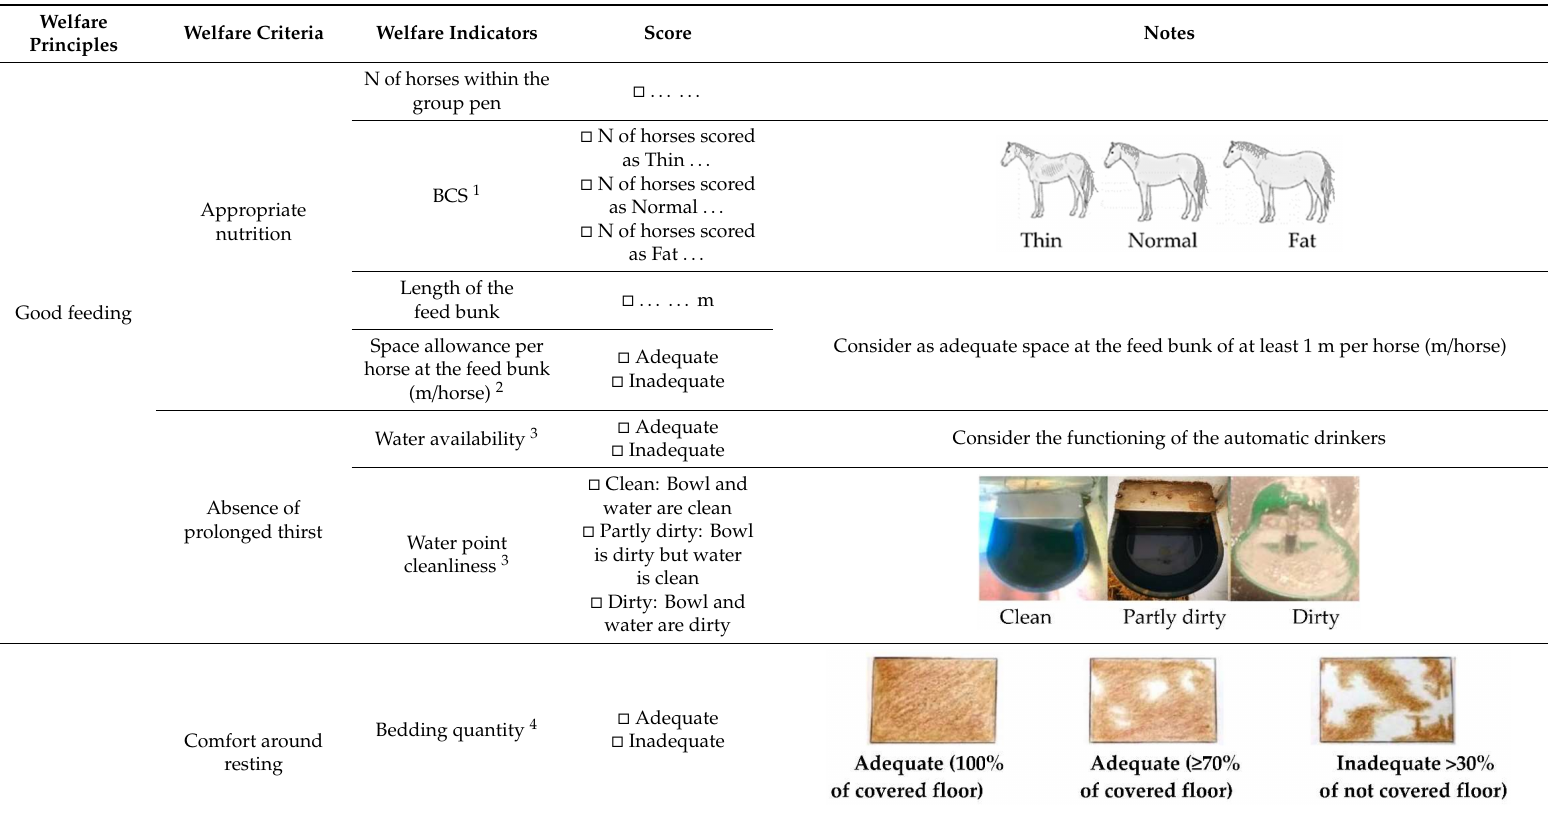
Table 2. Welfare assessment checklist used in each of the seven surveys. The checklist is divided into four sections corresponding to the Welfare Quality ® principles: good feeding, good housing, good health, and appropriate behaviour. Each principle is measured using specific resource-based, management-based, and animal-based indicators. Each section is accompanied by detailed guidance notes and photographs illustrating the